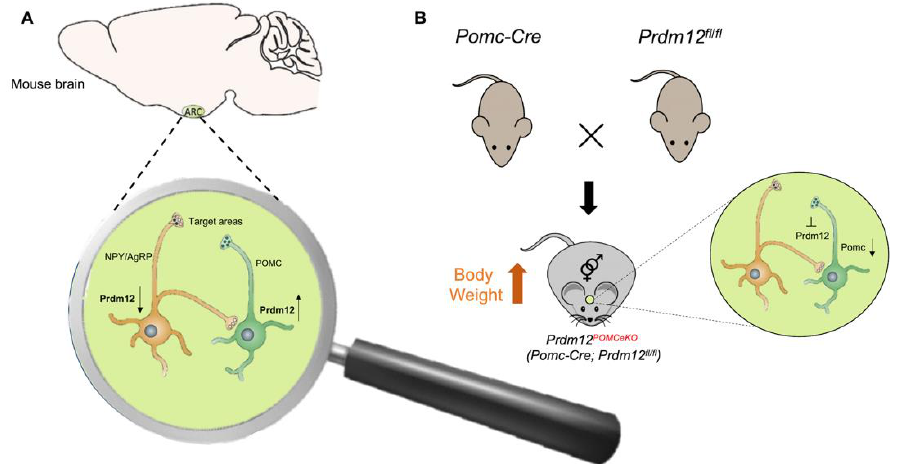
Figure 4. Possible mechanism of PRDM12 in POMC neurons. ( A ) PRDM12 expression level in POMC and NPY/AgRP neurons in the arcuate nucleus of the hypothalamus (ARH) in mouse brain. ( B ) To study the role of PRDM12 specifically in postmitotic POMC neurons, Pomc-Cre mice were bred with Prdm12fl/fl mice to generate Pomc-Cre ; in Prdm12fl/fl mice Prdm12 was selectively deleted in embryonic POMC neurons (designated as Prdm12POMCeKO mice). The expression of Npy and Agrp remained unaffected. Prdm12POMCeKO mice lacking Prdm12 selectively from POMC neurons showed a considerable reduction in Pomc mRNA levels that led to severe obesity.